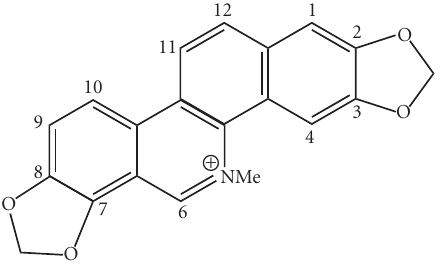
Figure 4: Molecular structure of sanguinarine. One of the best tar- gets for testing interaction of a drug with its receptor is DNA. Anti- tumor antibiotics are known to act at the DNA level. Due to DNA’s helical and relatively stable conformation in solution, DNA-drug complexes can conveniently be studied by high-resolution NMR- spectroscopy.